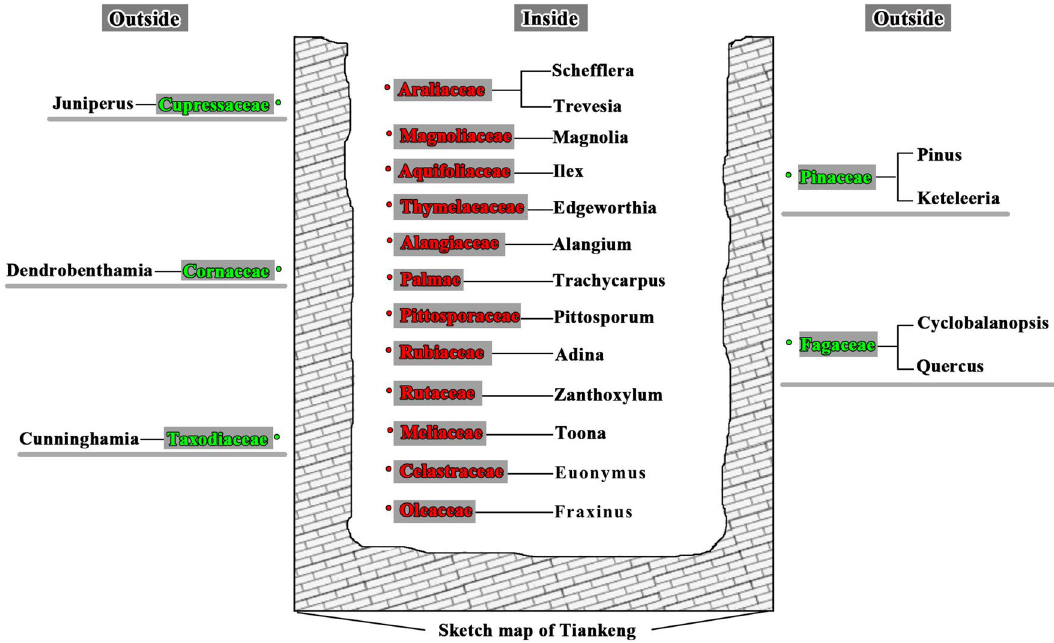
Figure 1. Arbor comparison between inside-tiankeng and outside-tiankeng.